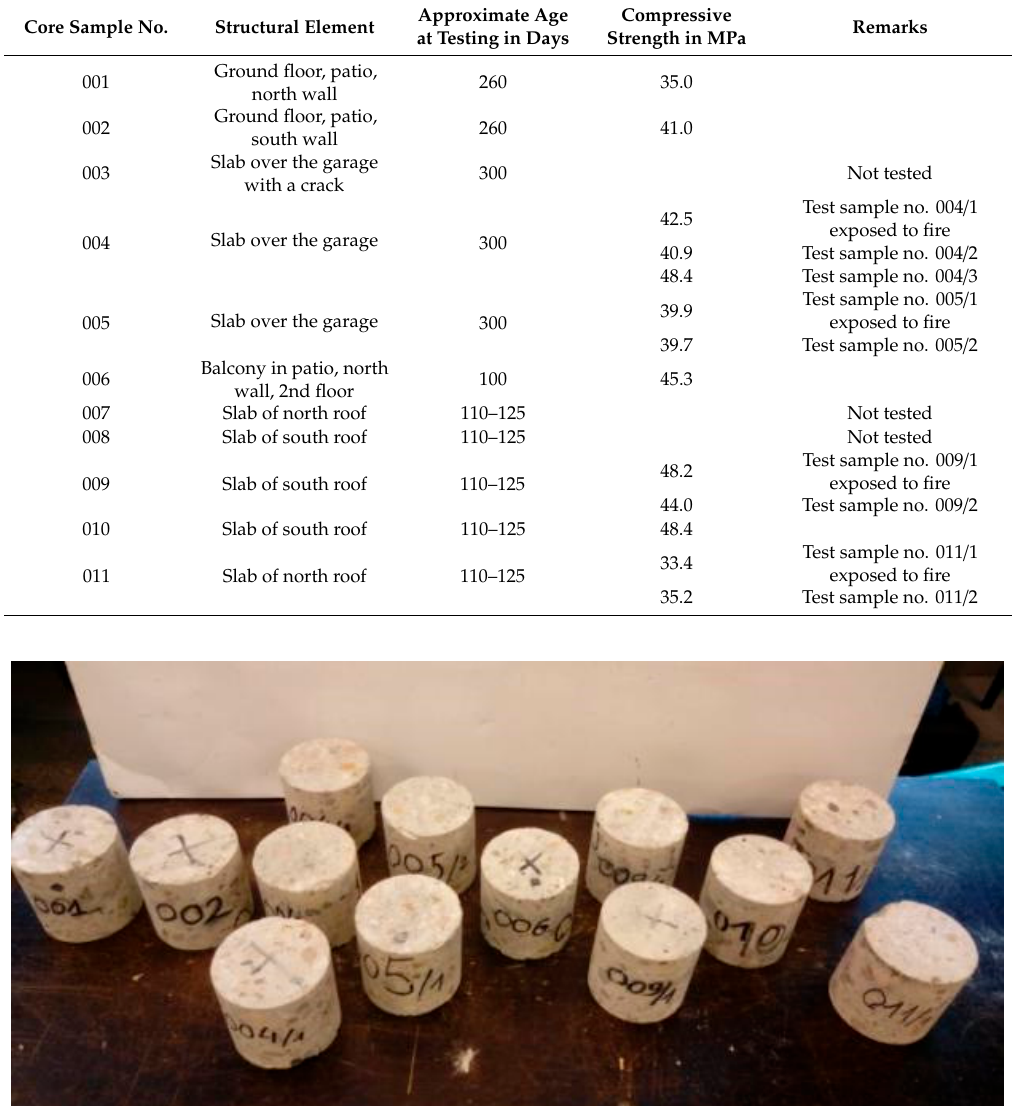
Figure 6. Core samples prepared for the strength test (height 100 mm).